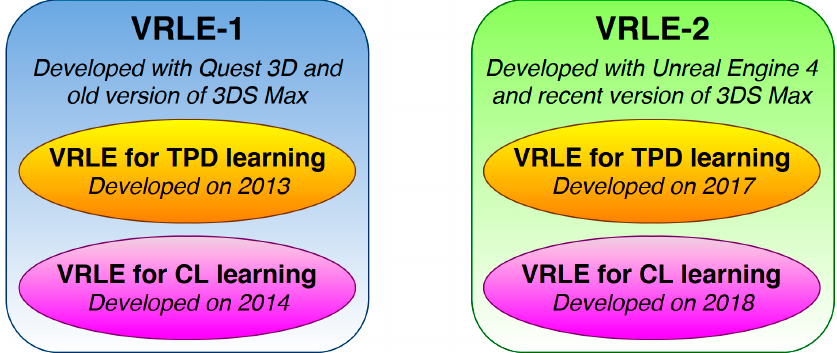
Figure 1. Classification of the VRLEs analyzed in this study: (i) former versions, VRLE-1 (left-hand side); and (ii) more recently developed versions, VRLE-2 (right-hand side).